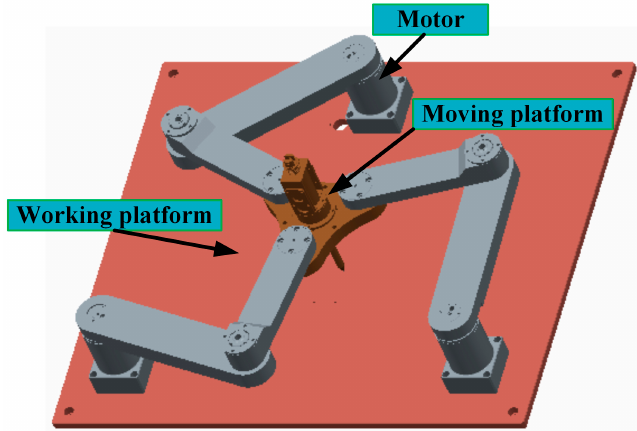
Figure 1. Three-dimensional map of the 3-Revolute–Revolute–Revolute (3-RRR) parallel robot.